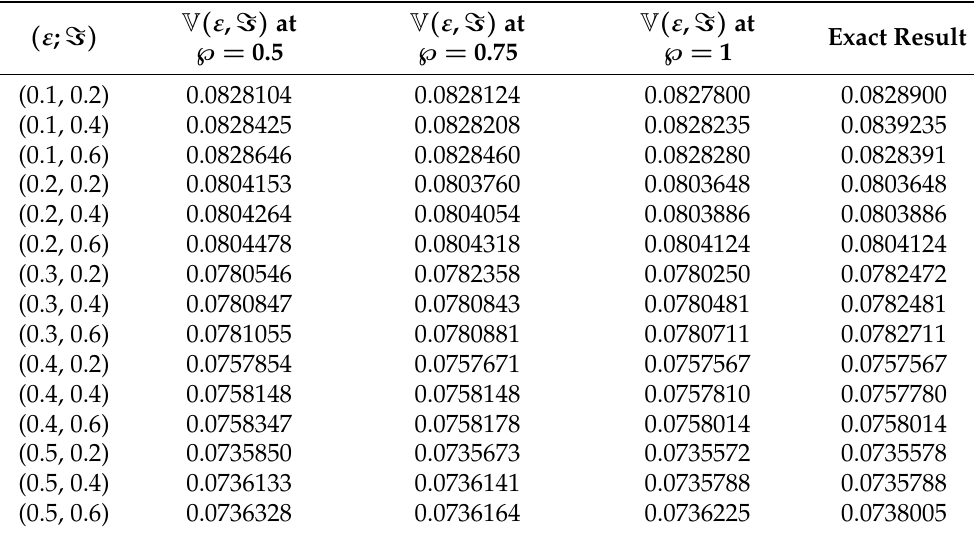
Table 2. YDM solution of V ( ε , (cid:61) ) at various fractional-order ℘ of Example 1.